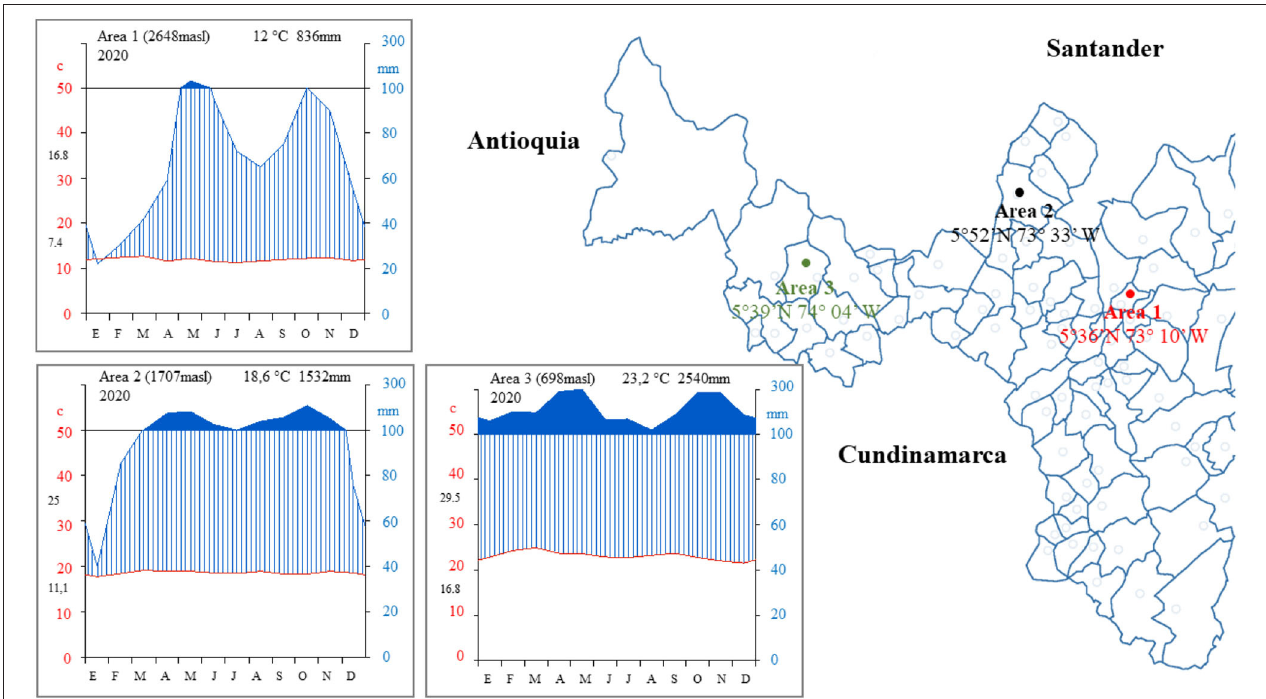
FIGURE 1 | Study area. Department of Boyacá, Colombia, South America. Climatic conditions of the three study